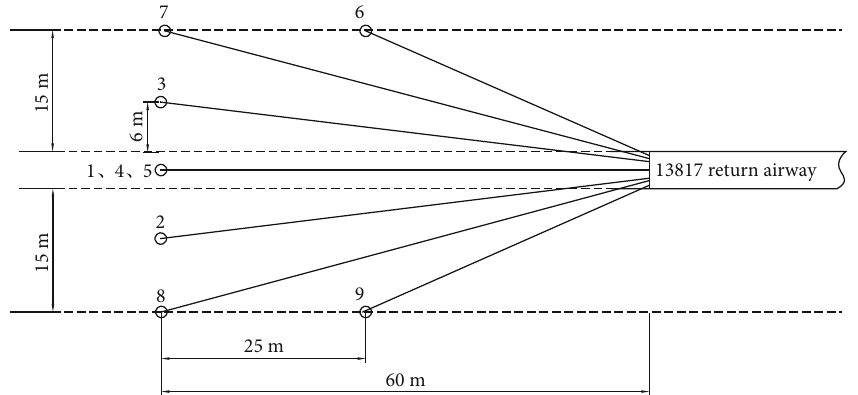
Figure 16: 13817 drainage borehole layout plan of return airway.